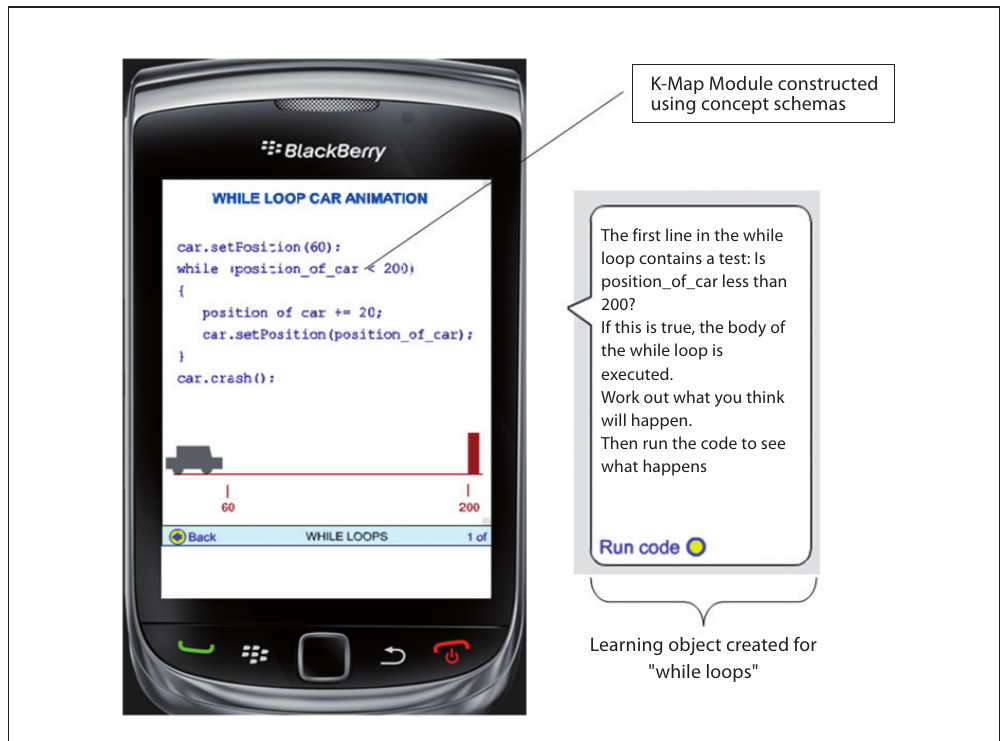
Figure 7 mLearning with K-Map (Example of learning objects created within the page for “while